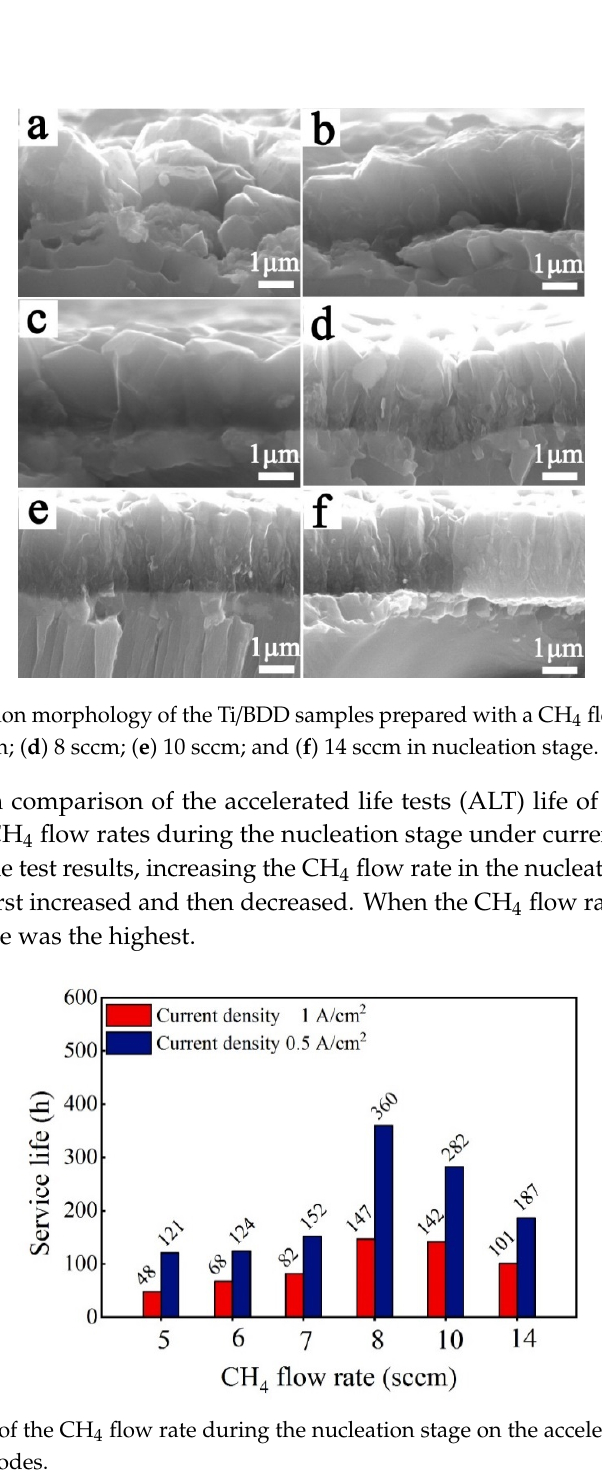
Figure 1. Morphology of Boron doped diamond (BDD) coatings deposited for 2 h at different CH 4 133 flow rates:( a ) 4 sccm; ( b ) 6 sccm; ( c ) 7 sccm; ( d ) 8 sccm; ( e ) 10 sccm; ( f ) 14 sccm. 134